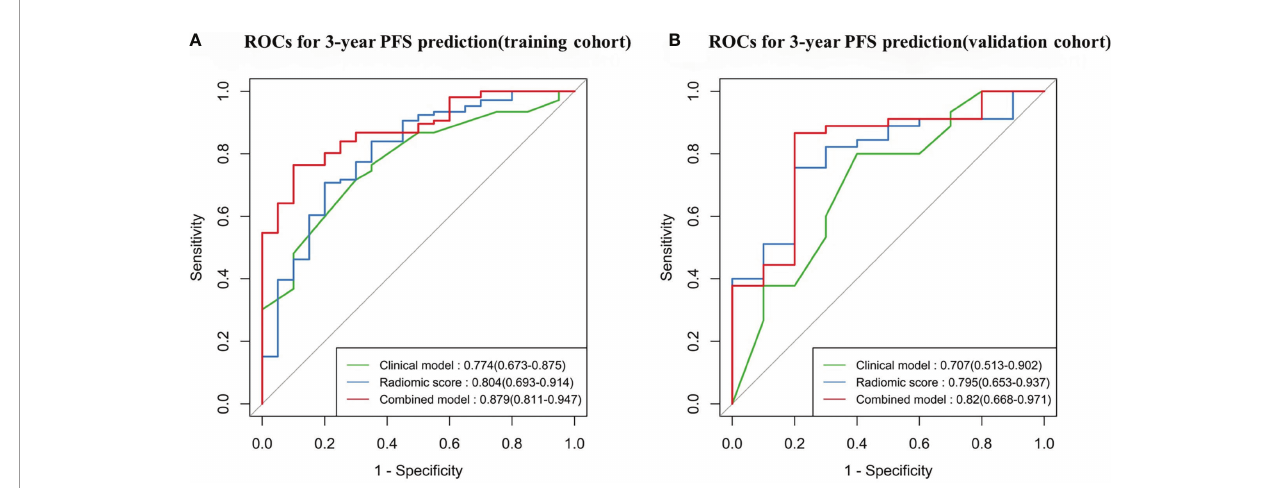
FIGURE 5 | Time-dependent receiver operating characteristic (ROC) curves comparing the predictive capacity of the three models. (A) Training cohort, N = 126. (B) Validation cohort, N = 55. PFS, progression-free